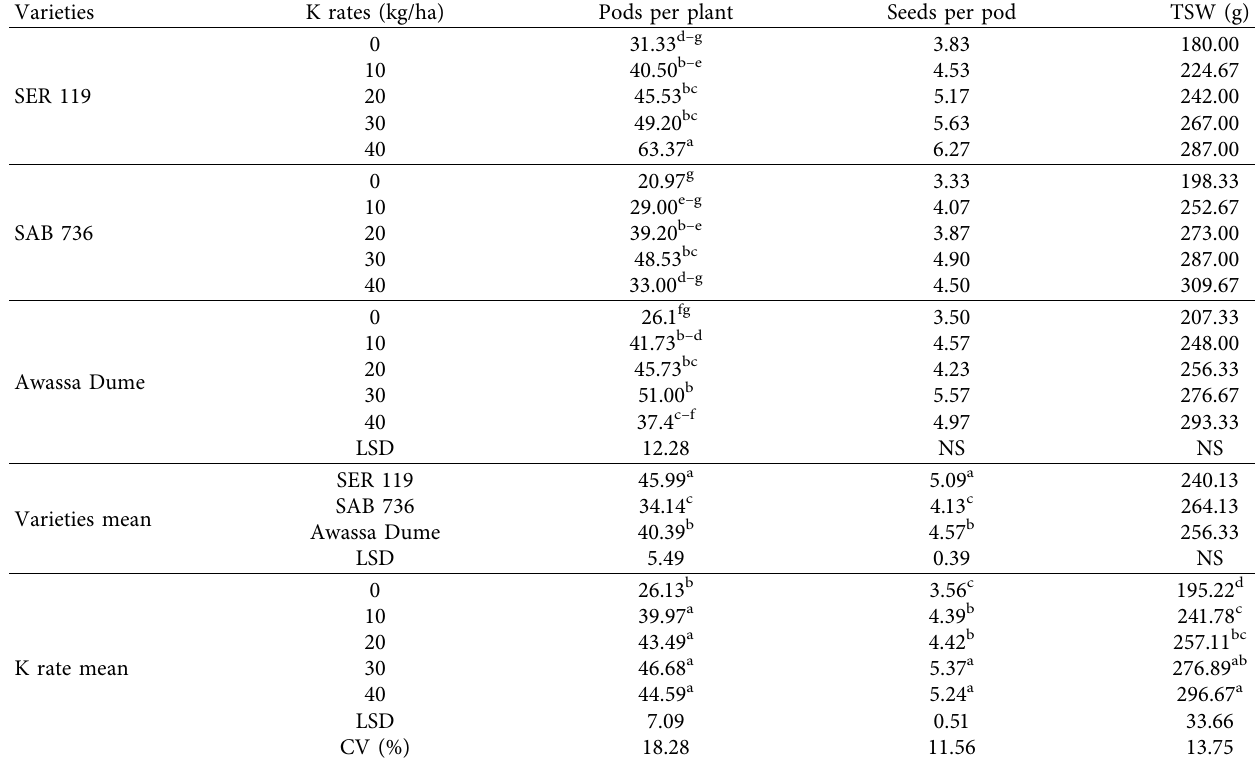
Table 3: Pods per plant, seeds per pod, and TSW as afected by varieties and K rates during 2019/20 cropping seasons. Varieties K rates